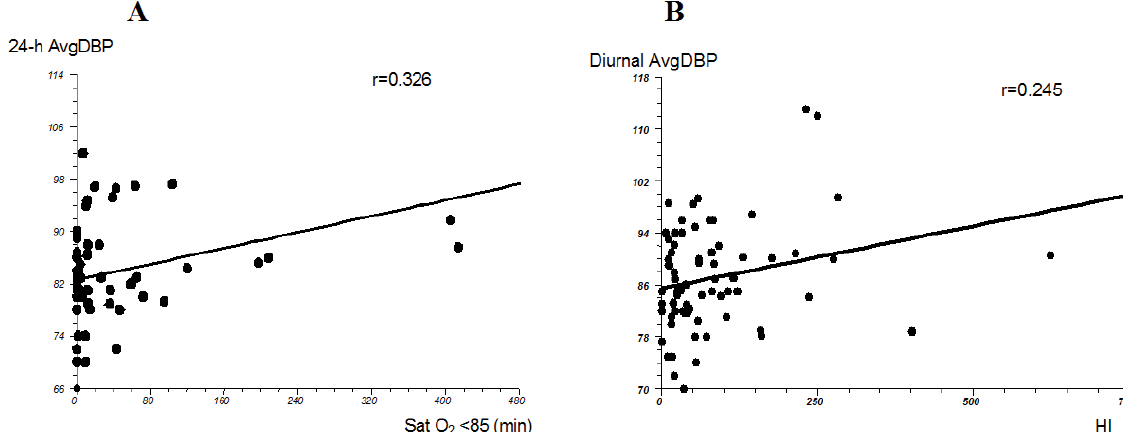
) <85% in minutes (A) and 2